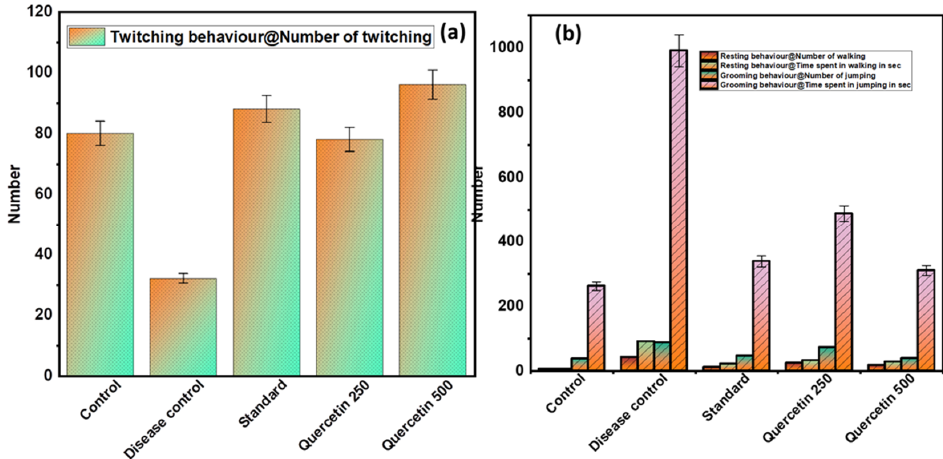
Figure 3. ( a ) Effect of Quercetin on freezing behavior (twitching); ( b ) effect of Quercetin on immobile posture or sleeping (resting and grooming behavior).